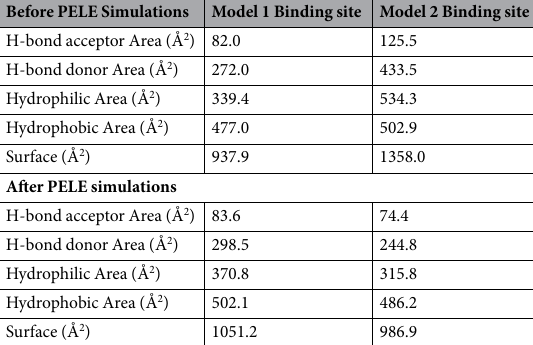
Table 1. Comparison of the binding sites of model 1 and model 2.